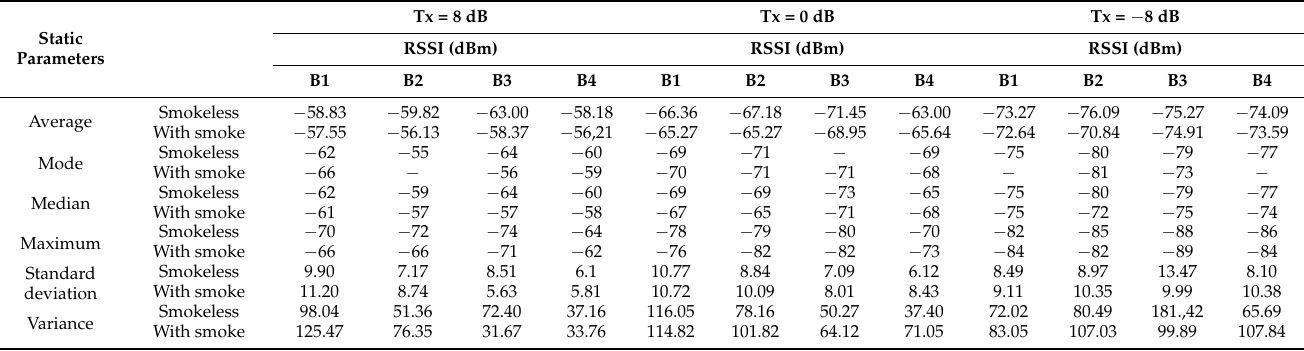
Table 1. Real RRSI results obtained in the test.